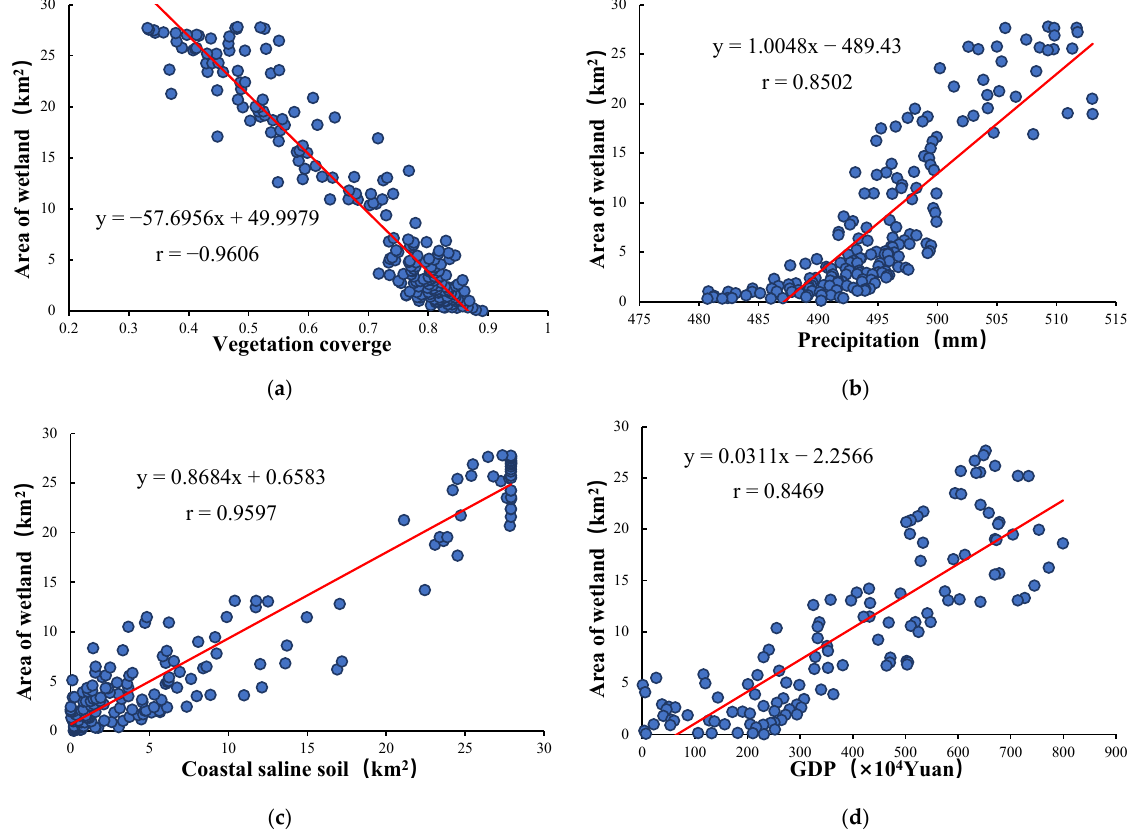
Figure 11. Correlation between wetland area and driving factors. ( a ) Vegetation coverage; ( b ) Precipitation; ( c ) Coastal saline soil area; ( d ) GDP.